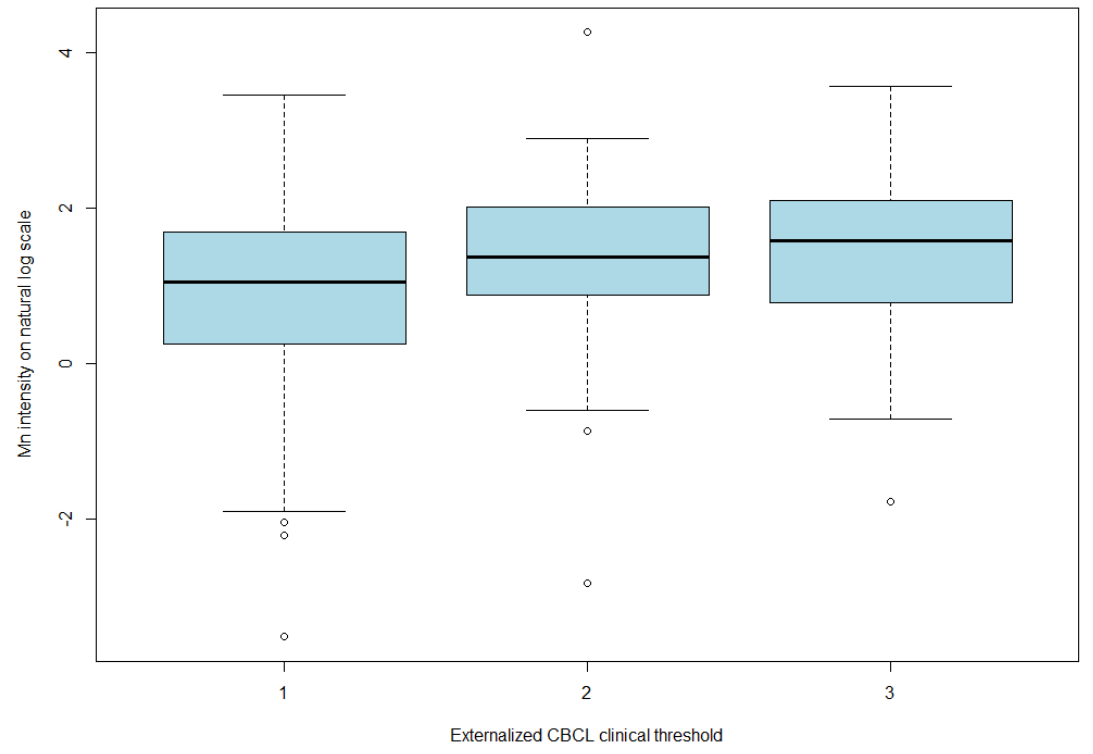
Figure 1. Mn intensity on natural log scale by clinical group of externalized CBCL. Table 2. Distribution of Fe, Cu, and boron by quartile and clinical defined group of externalizing